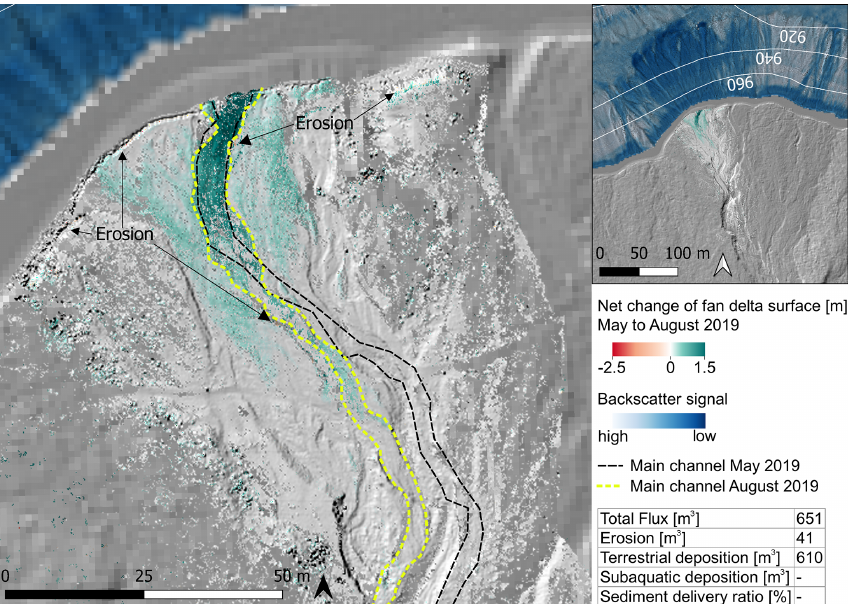
Figure 5. Net topography change of the shallow, mature fan delta with a 1.19km 2 catchment between 10 May and 22 August 2019 calculated from surface comparison of TLS data. The total sediment flux (i.e. total eroded and deposited volume on the lidar-covered fan delta) is lower compared to the juvenile fan delta in Fig. 4. Deposition dominates and linear erosion occurs accessorily on the channel bank and parallel to the shoreline. The mature fan delta is dominated by terrestrial deposition, and no sediment flux into the lake was detected. The main channel and levees were preserved in the lower fan area. This fan type shows a stable morphology and widespread onshore deposition. Onshore DEM is derived from Land Tirol (https://data.tirol.gv.at, last access: 31 January 2021).